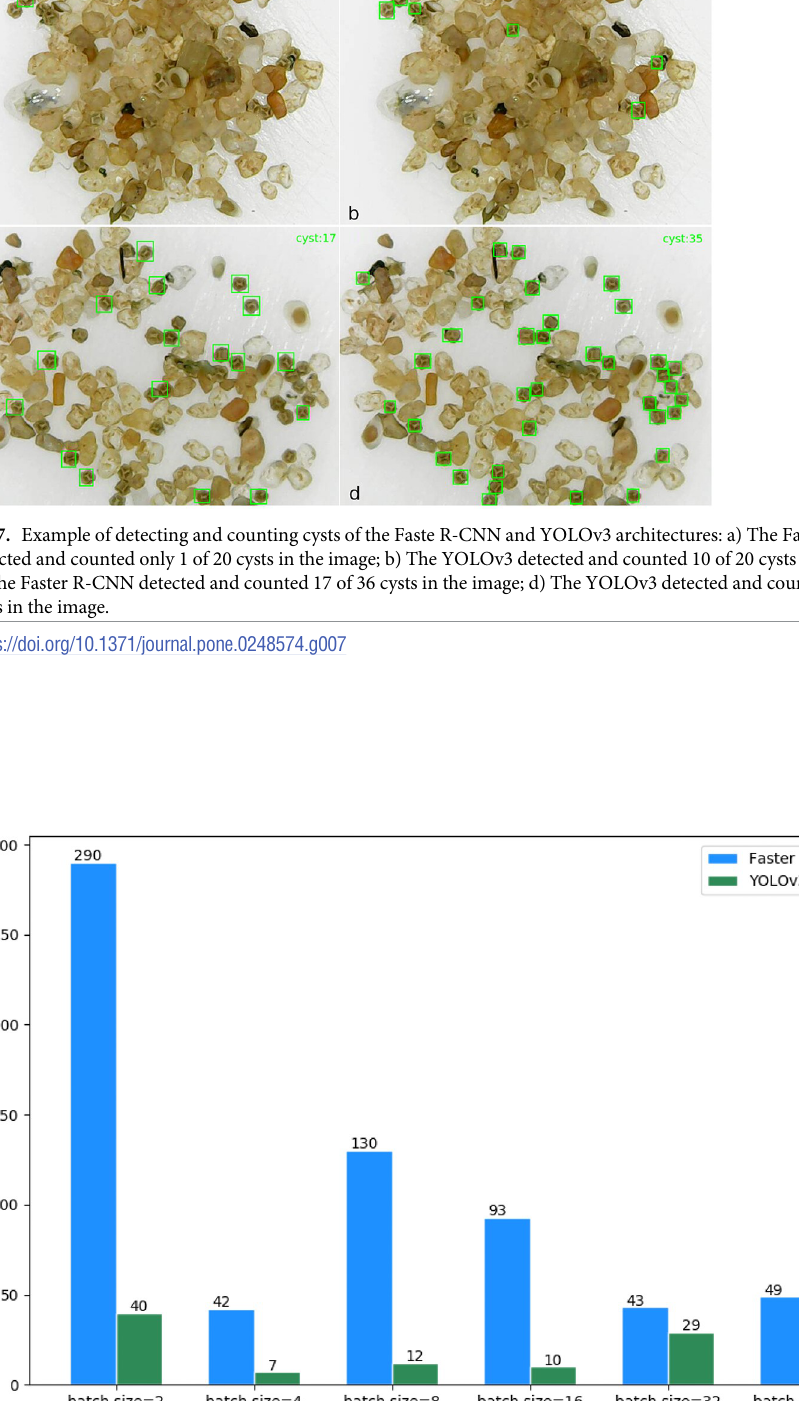
PLOS ONE | https://doi.org/10.1371/journal.pone.0248574 March 18,